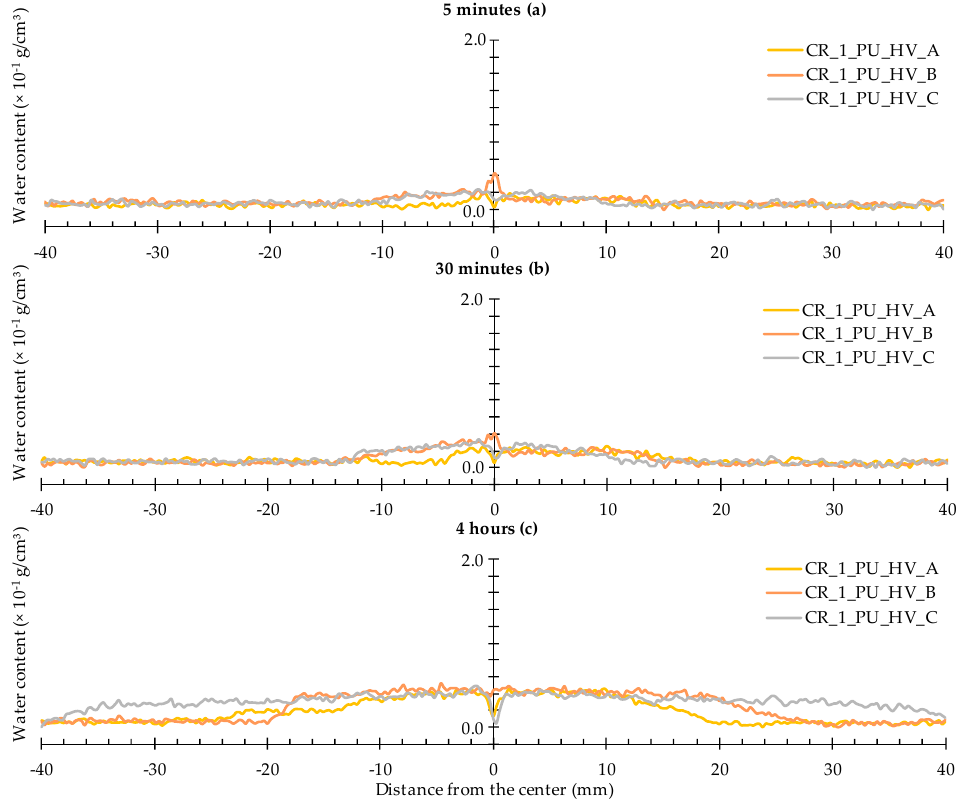
Figure 12. Water profiles of the three standard mortar prisms containing one artificial crack healed with PU_HV: ( a ) after 5 min; ( b ) after 30 min; and ( c ) after 4 h.